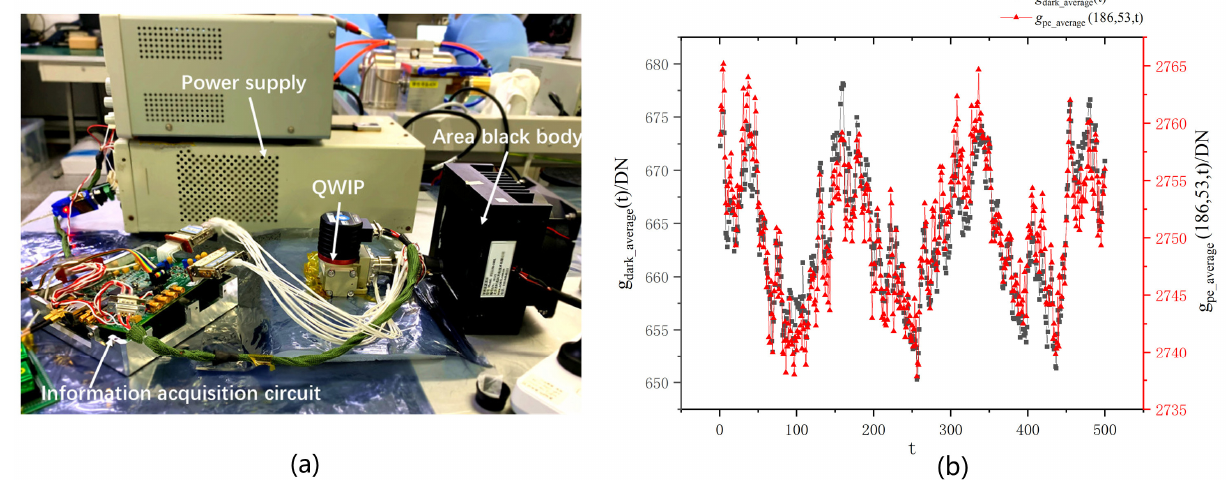
Figure 8. Position of the selected pixels.